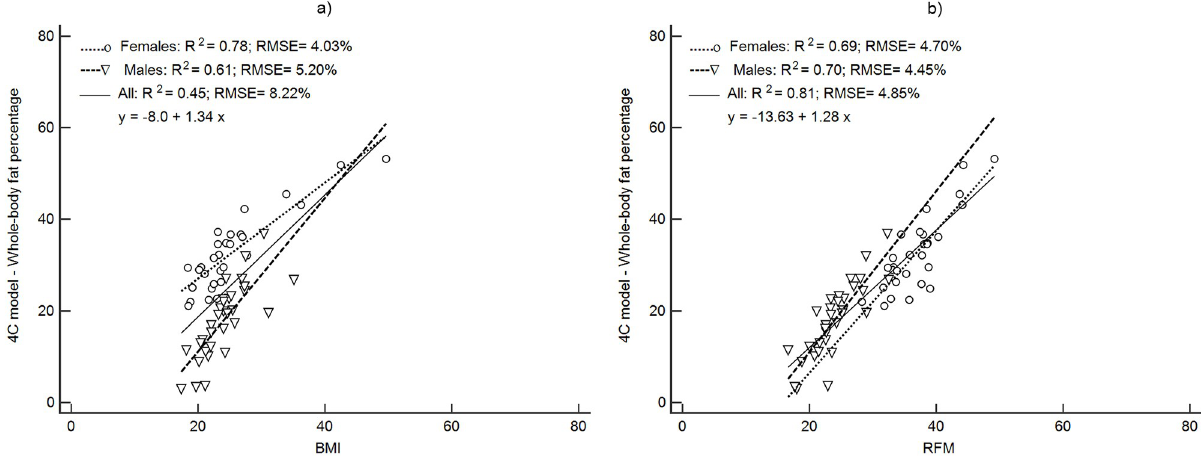
Fig 4. Prediction of FM% from BMI and RFM using 4C model as a body composition method. Abbreviations: BMI, body mass index; RFM, relative fat mass; RMSE, root mean squared error; 4C model, 4-compartment model.